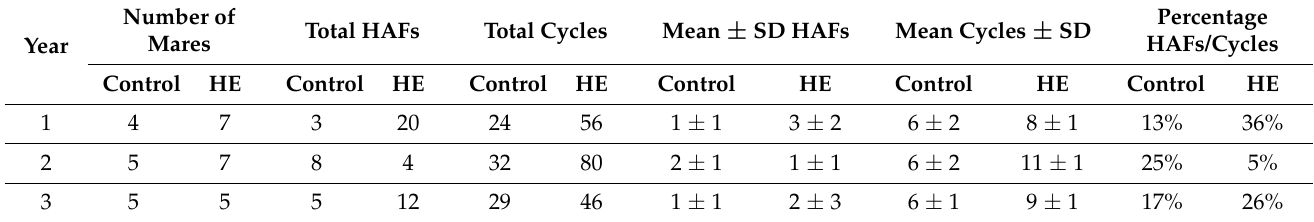
Table 2. Total and mean ± SD number of hemorrhagic anovulatory follicles (HAFs) and cycles, and the percentage of HAFs/cycles for the control and high-energy (HE) groups per diet year (years 1–3), with the corresponding number of mares per